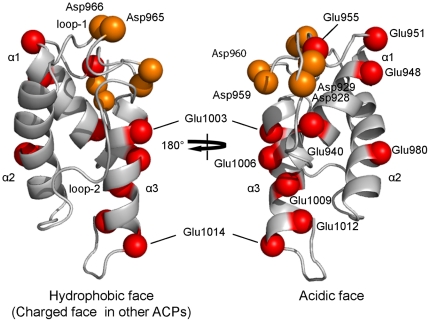
Ribbon representation of apo-meACP with either hydrophobic or acidic face.The hydrophobic and Glu-Asp acidic faces are shown with highlighted spheres colored red (Glu) and orange (Asp).